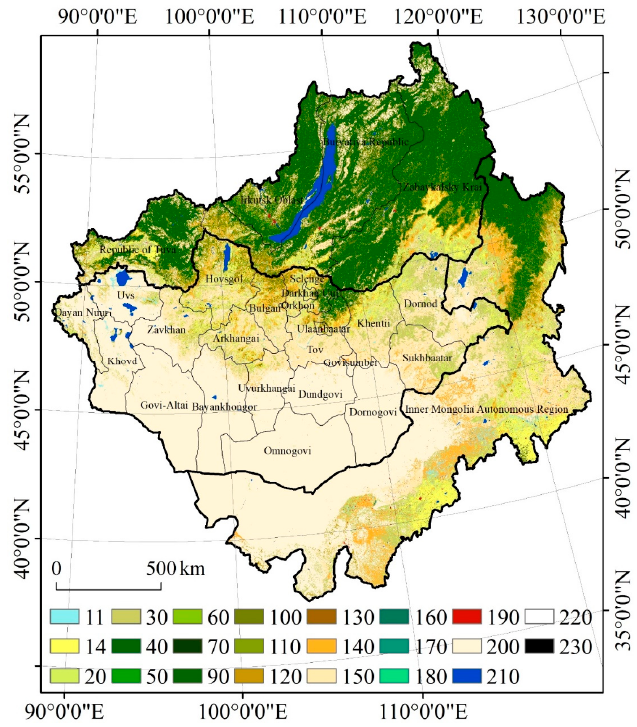
Figure 2. Land cover map of the MP based on the ESA GlobCover 2009. The numbers in the legend represent different types of land cover, corresponding to the land cover code in the Table 2. Table 2. Classification of GlobCover 2009 land cover types [56].